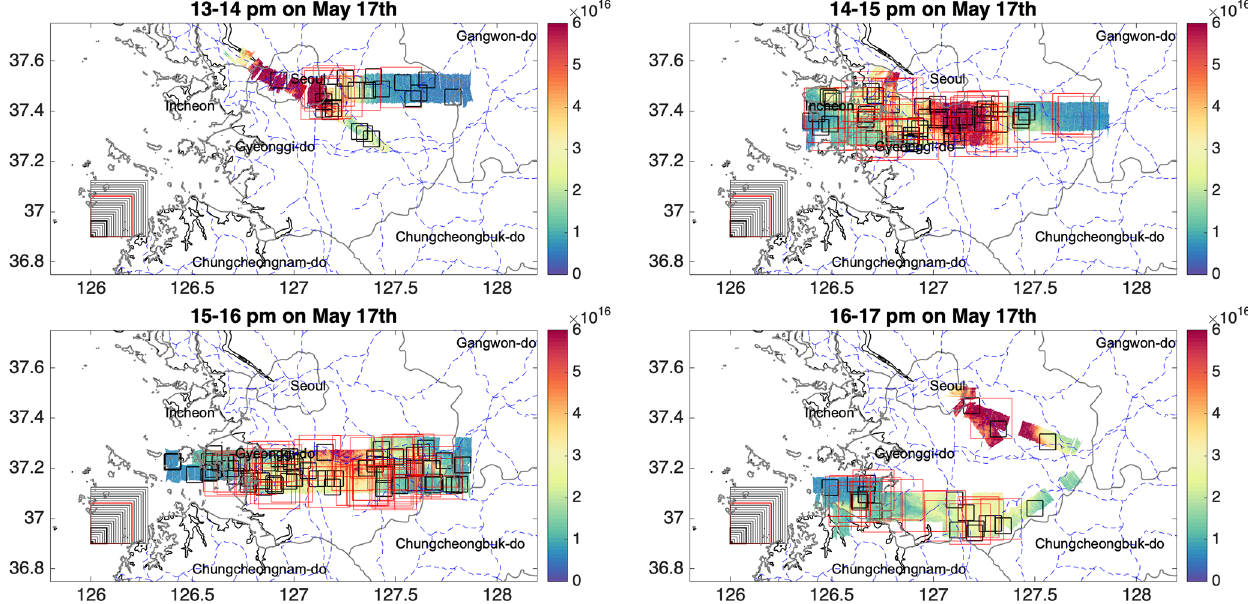
Figure 3. Demonstration of the hypothetical satellite pixel random sampling method. Each subplot is 1h during the 17 May PM flight. For each hour, we randomly sample 10000 hypothetical satellite pixels at each different pixel size (i.e., 0 . 5km × 0 . 5km, 0 . 75km × 0 . 75km, 1km × 1km, 2km × 2km ,..., 25km × 25km) over the GeoTASO data of tropospheric NO 2 vertical column (molec.cm − 2 ) every hour. The sampled pixel size (from 0 . 5km × 0 . 5km to 25km × 25km) are shown in the lower-left corner of each sub-plot. Only 100 samples for pixel size of 7km × 7km (thick black box) and 100 samples for 18km × 18km are shown for demonstration purposes. Samples that fail to pass the 75% coverage threshold are not shown. Coastlines and provincial and metropolitan city boundaries are shown by solid gray lines. Main roads are shown by dashed blue lines (data are from http://www.diva-gis.org/gdata, last access: 7 June